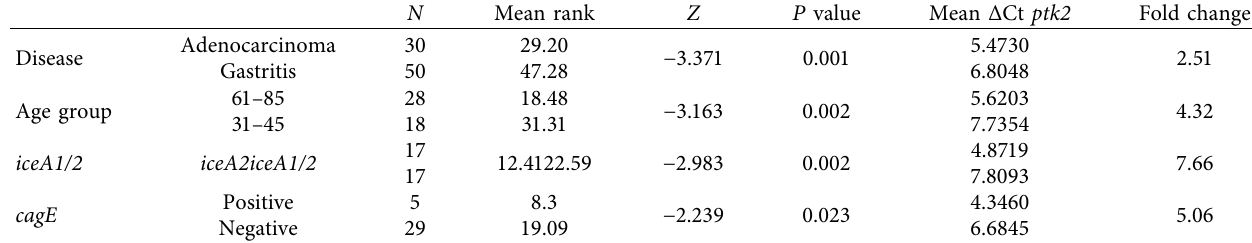
Table 8: The statistical relationships of ptk2 genes expression with H. pylori infection and its virulence genes expression using Man- n–Whitney U test. Fold changes of ptk2 gene expression were calculated by using the average of ptk2 Δ Ct in the case and control groups ( P < 0 . 05).